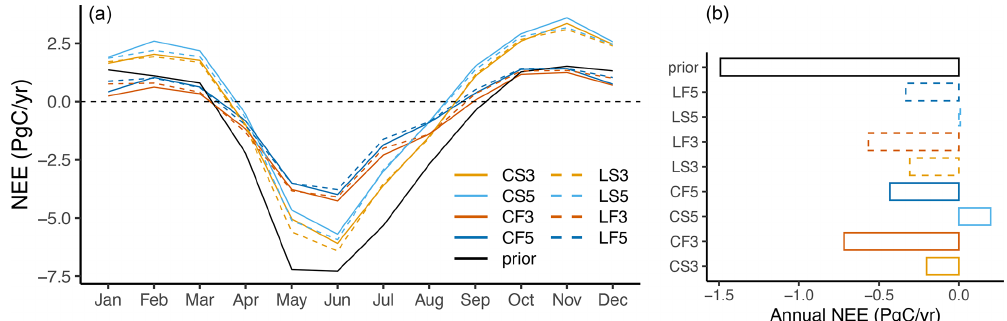
Figure 1. Panel (a) refers to a posteriori monthly NEE estimated using eight inversions, including a priori NEE shown in black, with CSR (solid lines) and LUMIA (dashed lines), and panels (b) denotes the corresponding annually aggregated fluxes. Orange and red colours correspond to TM3, and dark or light blue correspond to TM5. Orange and light blue colours refer to STILT, and red and dark blue refer to FLEXPART.